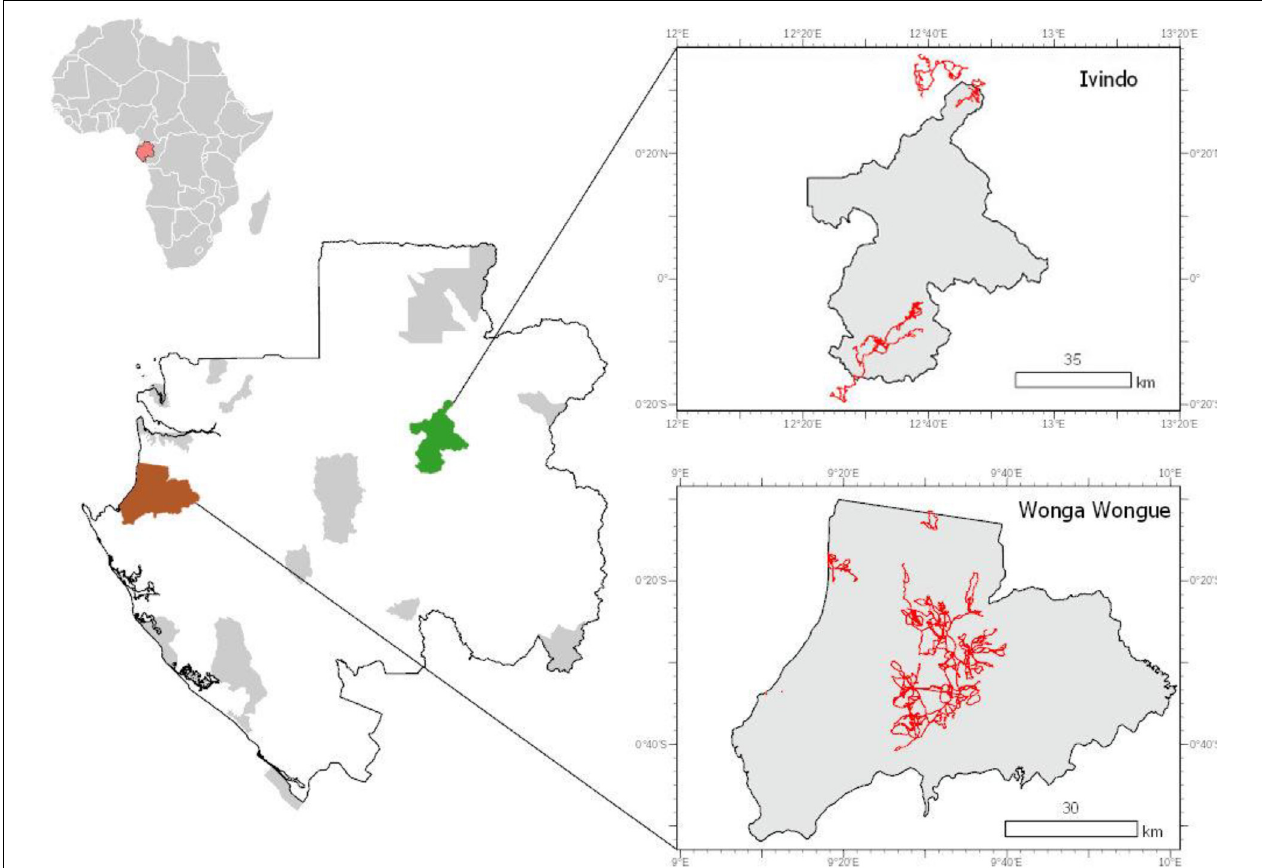
FIGURE 1 | The location of study sites and distribution of follow effort within Gabon, central Africa. The top-left inset shows the location of Gabon (red) in Africa; the left hand panel shows the two focal protected areas (green = Ivindo; orange = Wonga Wongué); and the right hand panel shows the tracks of research teams during focal elephant follows (red lines) within and around each protected area (gray